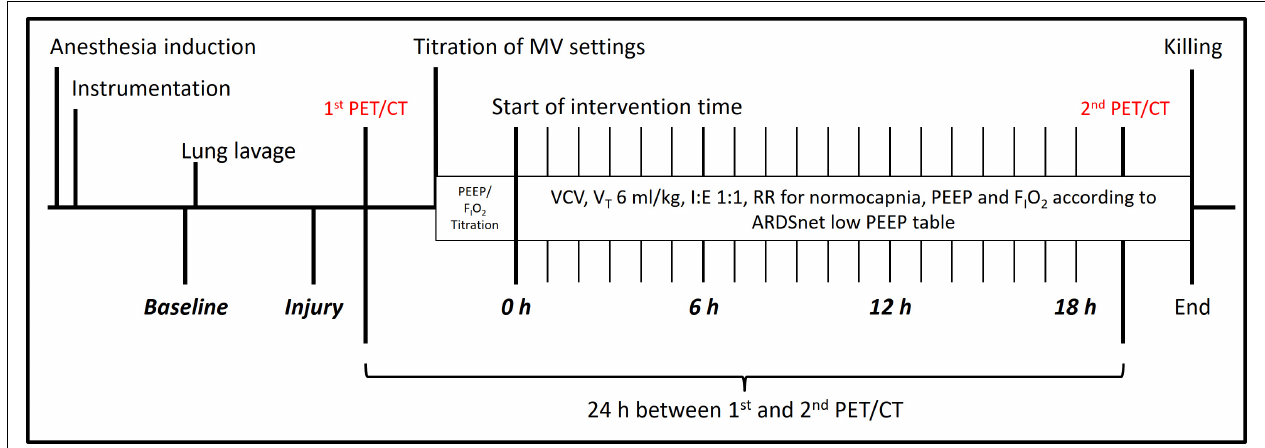
FIGURE 1 | Experimental time course. Experimental time course. PEEP, positive end-expiratory pressure; F I O 2 , inspiratory fraction of oxygen; VCV, volume-controlled ventilation; I:E, inspiratory to expiratory time ratio; RR, respiratory rate; ARDSnet, acute respiratory distress syndrome network.